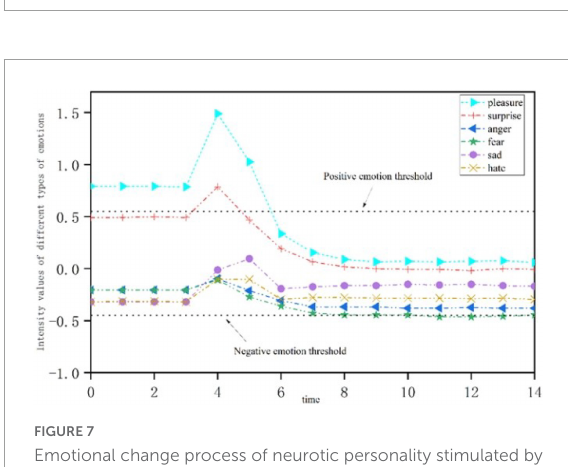
FIGURE8 Emotional change process of open personality stimulated by a single negative stress event.